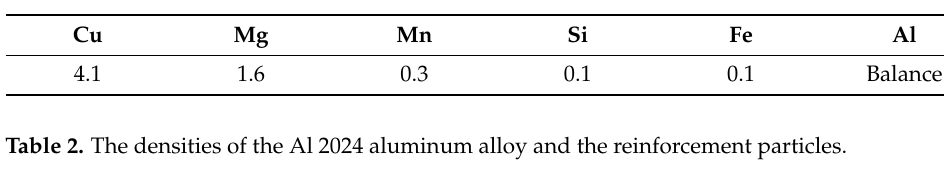
Table 1. Chemical composition of the as-received Al 2024 aluminum wt.%.